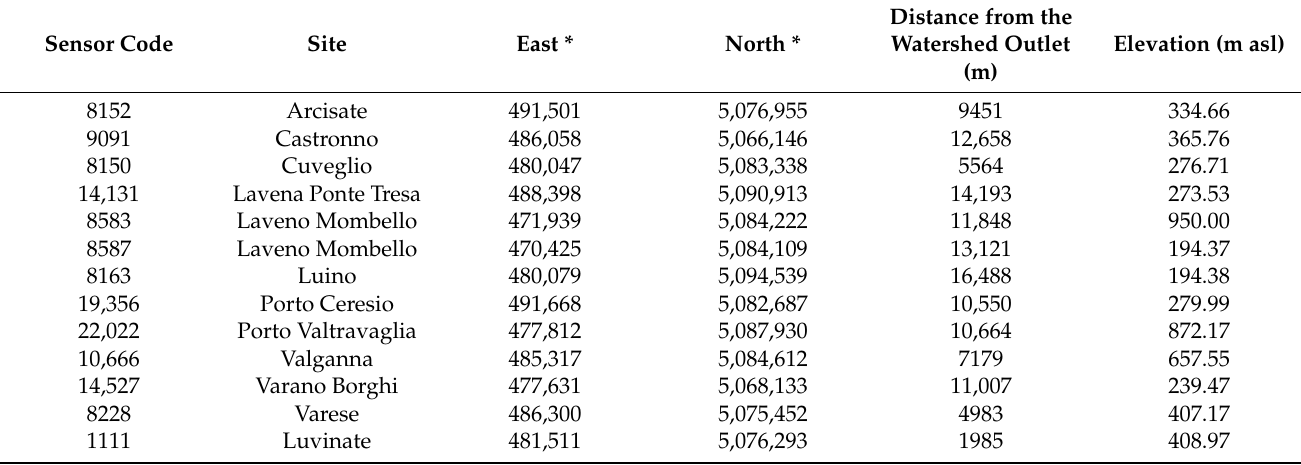
Table 2. Coordinates of the rain-gauge stations and their distance from the watershed outlet.